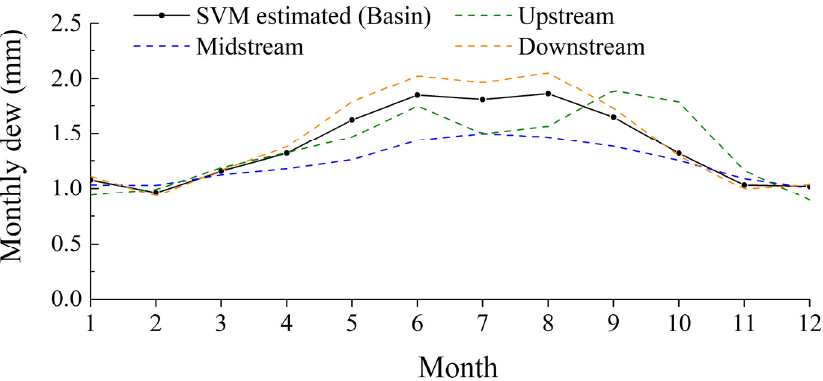
Figure 8. Basin-scale monthly dew yields estimated using SVM.